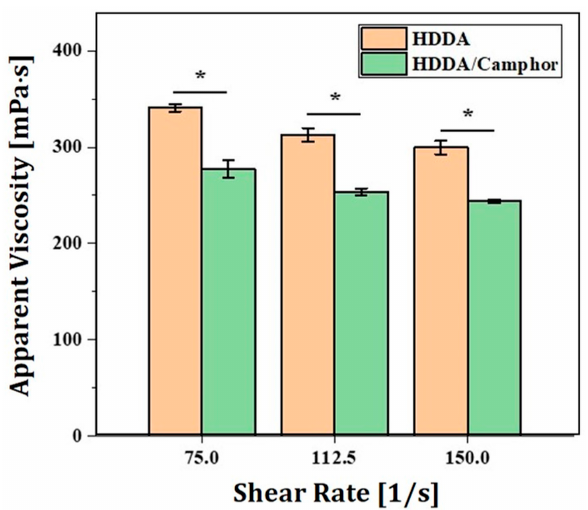
Figure 4. Apparent viscosities at various shear rates observed for 4Y-PSZ suspensions prepared using HDDA and HDDA/camphor vehicle (solid loading = 40 vol% and dispersant content = 4 wt%) (* p <